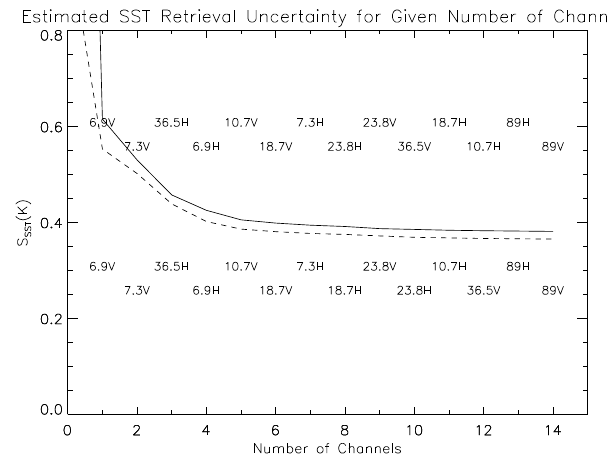
Figure 7. Estimated SST retrieval uncertainty against the number of AMSR2 channels used, for the best combination of the given number of channels, based on information content analysis. The new channel added to the set is indicated at each step and is chosen on the basis of minimizing the SST retrieval uncertainty. The upper set of channels and solid line come assume a four-variable retrieval vector and the lower set and dashed line assume a five-variable retrieval